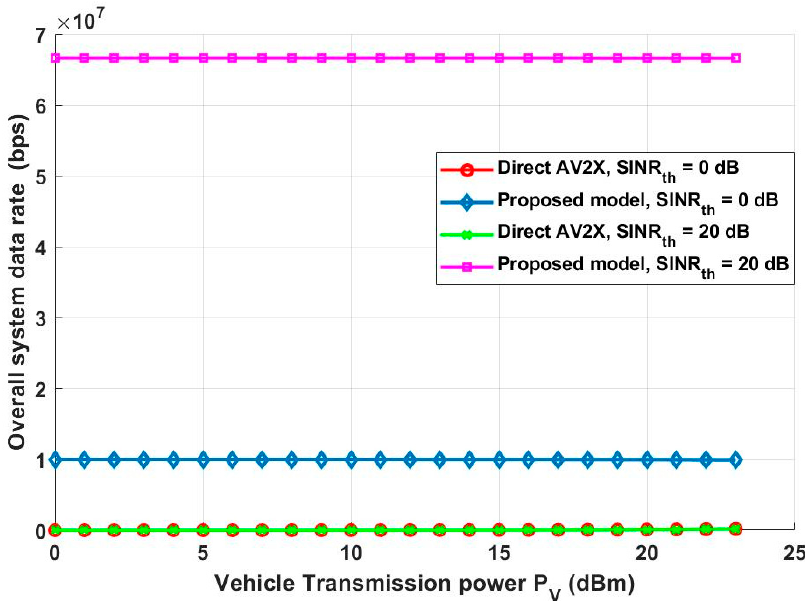
Figure 7. Vehicle transmission power vs. overall system data rate.